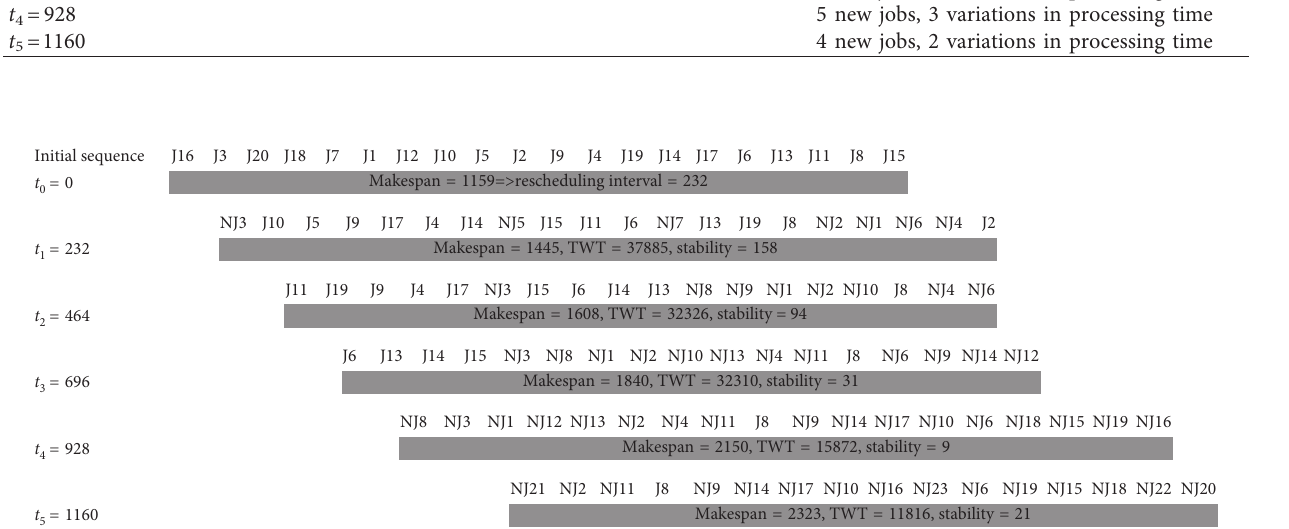
Figure 10: Schedule of jobs at the different rescheduling points in